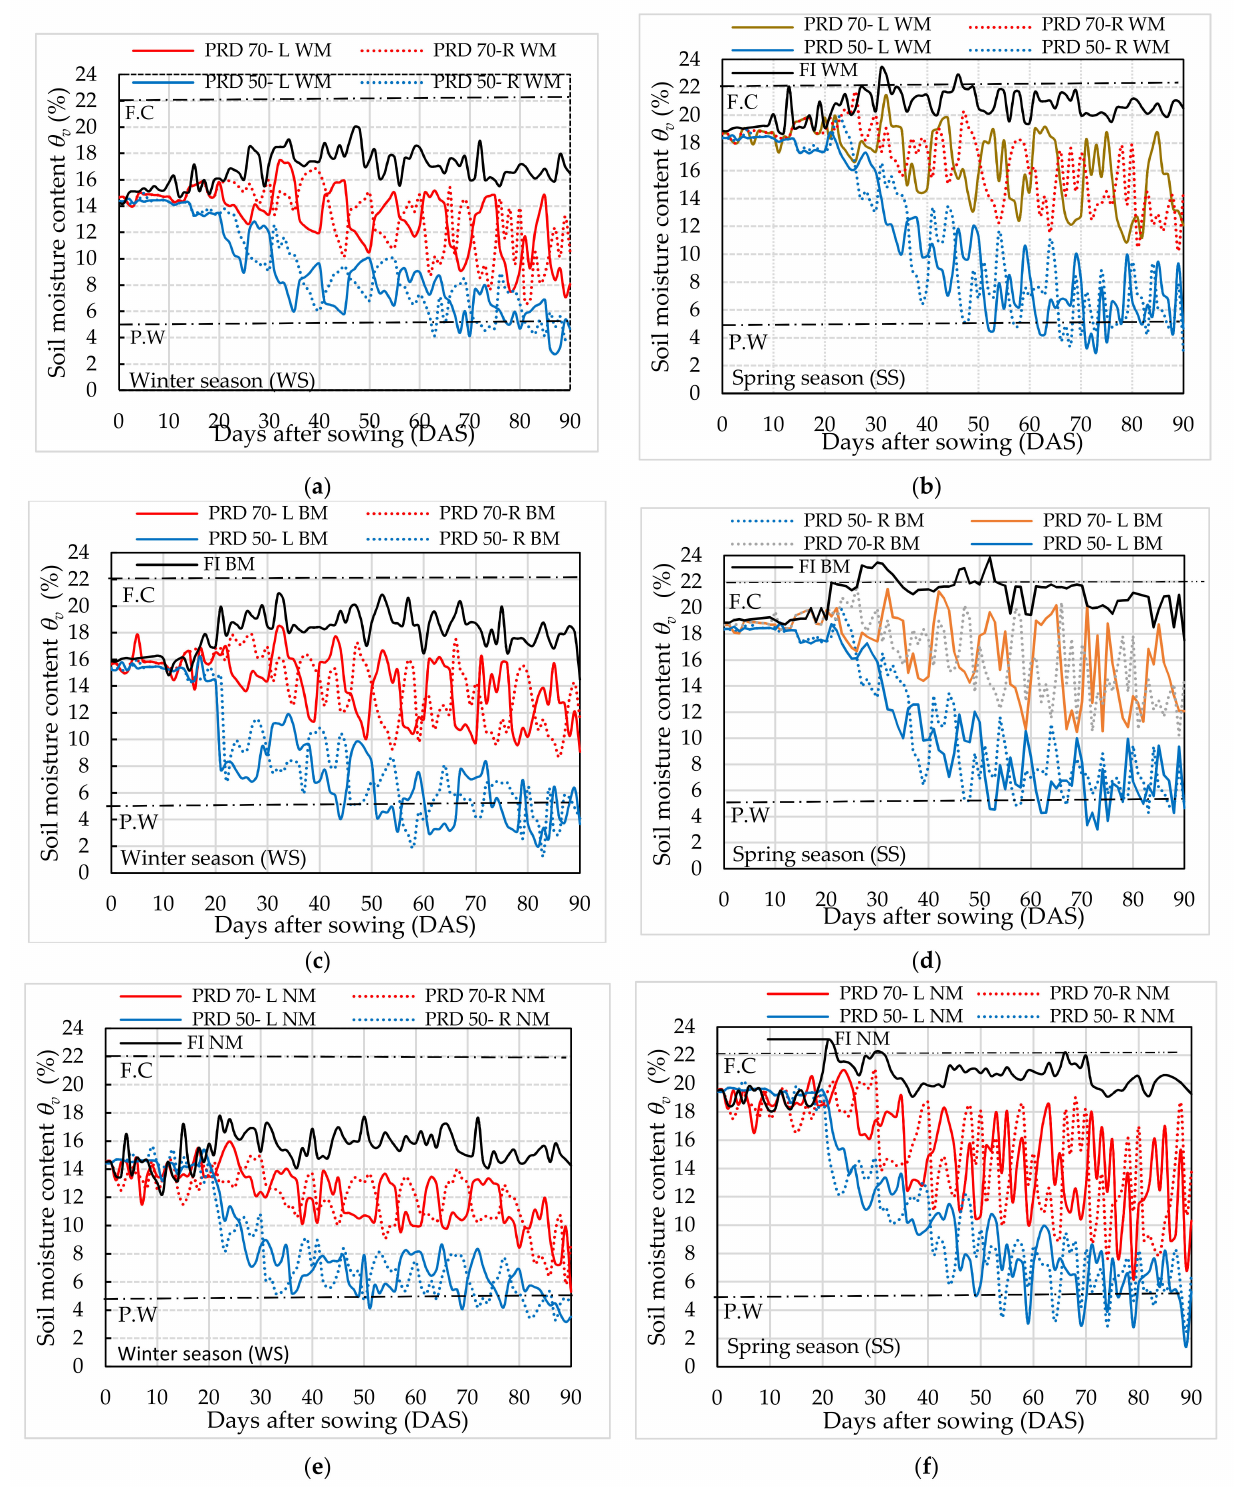
Figure 5. Soil moisture for full irrigation (FI) and deficit partial rootzone drying under 70% and 50% of evapotranspiration (PRD70 and PRD50, respectively) at the left (L) and right (R) rootzone sides combined with: ( a ) Transparent mulch (WM) during the winter season (WS), ( b ) WM during the spring season (SS), ( c ) black mulch (BM) during the WS, ( d ) BM during the SS, ( e ) no mulch (NM) during the WS, and ( f ) NM during SS. FC, field capacity, and WP, wilting